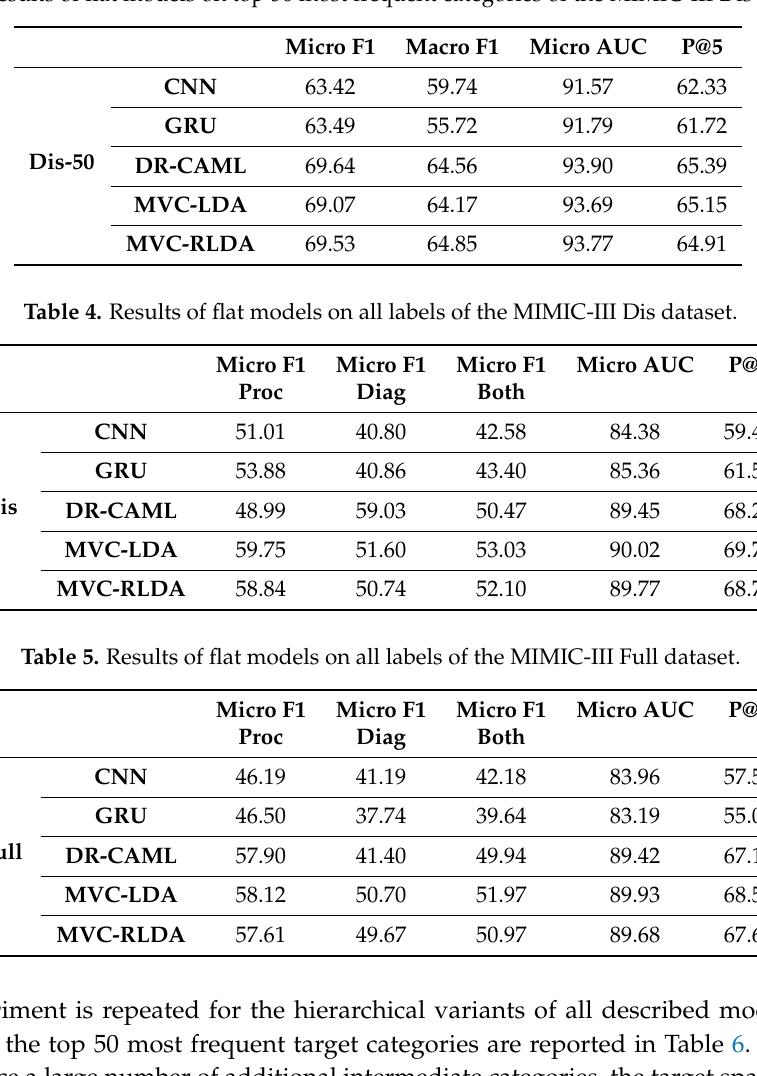
Table 3. Results of flat models on top 50 most frequent categories of the MIMIC-III Dis-50 dataset.